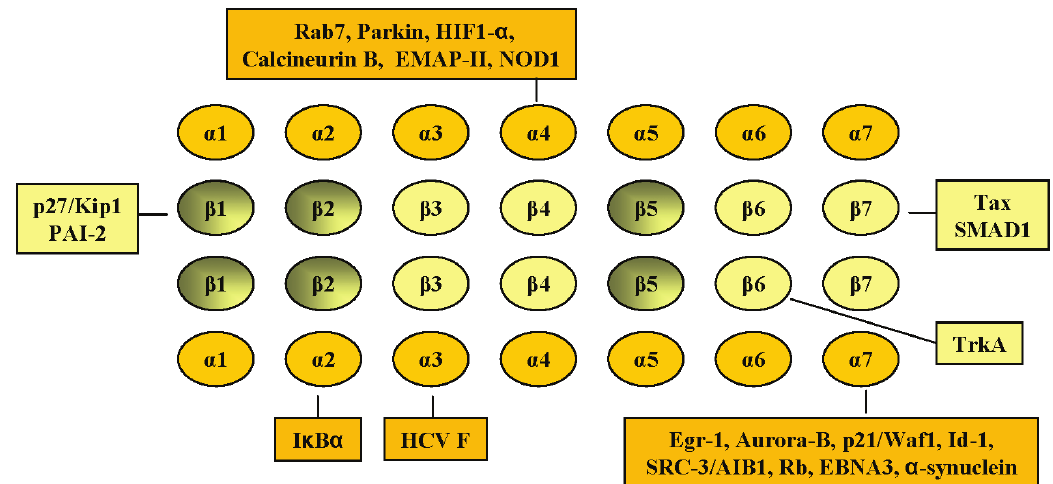
Figure 1. Schematic diagram of 20S proteasomal subunits and mammalian cellular proteins reported to interact with specific proteasomal subunits. The different (cid:2) subunits are shaded in bright yellow and the (cid:3) subunits are pale yellow. Active (cid:3) subunits ((cid:3)1, (cid:3)2 and (cid:3)5) are coloured black degraded to pale yellow. Mammalian proteins reported to interact with a specific proteasomal subunit are indicated by rectangular boxes. For further details refer to the main